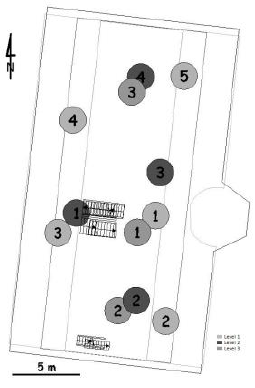
Figure 15: Location of viewpoints for virtual tour.